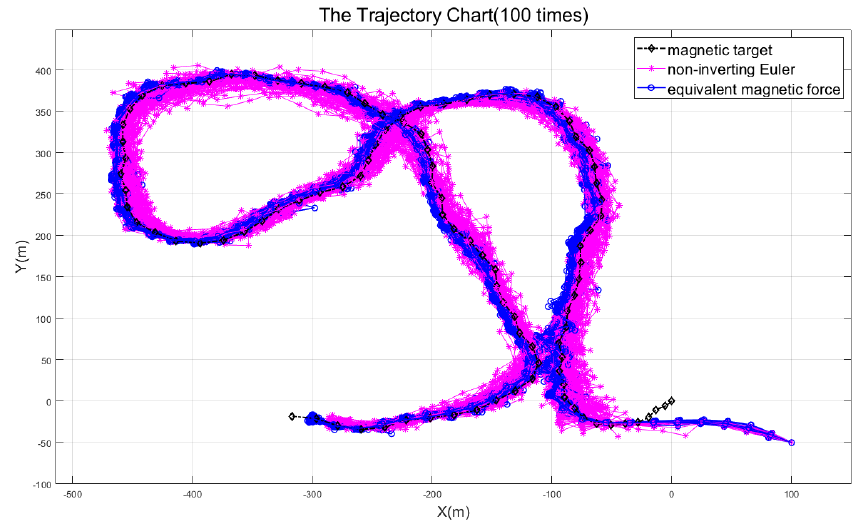
Figure 5. Robustness comparison diagram of the non-inverting Euler method and equivalent mag- netic force method.